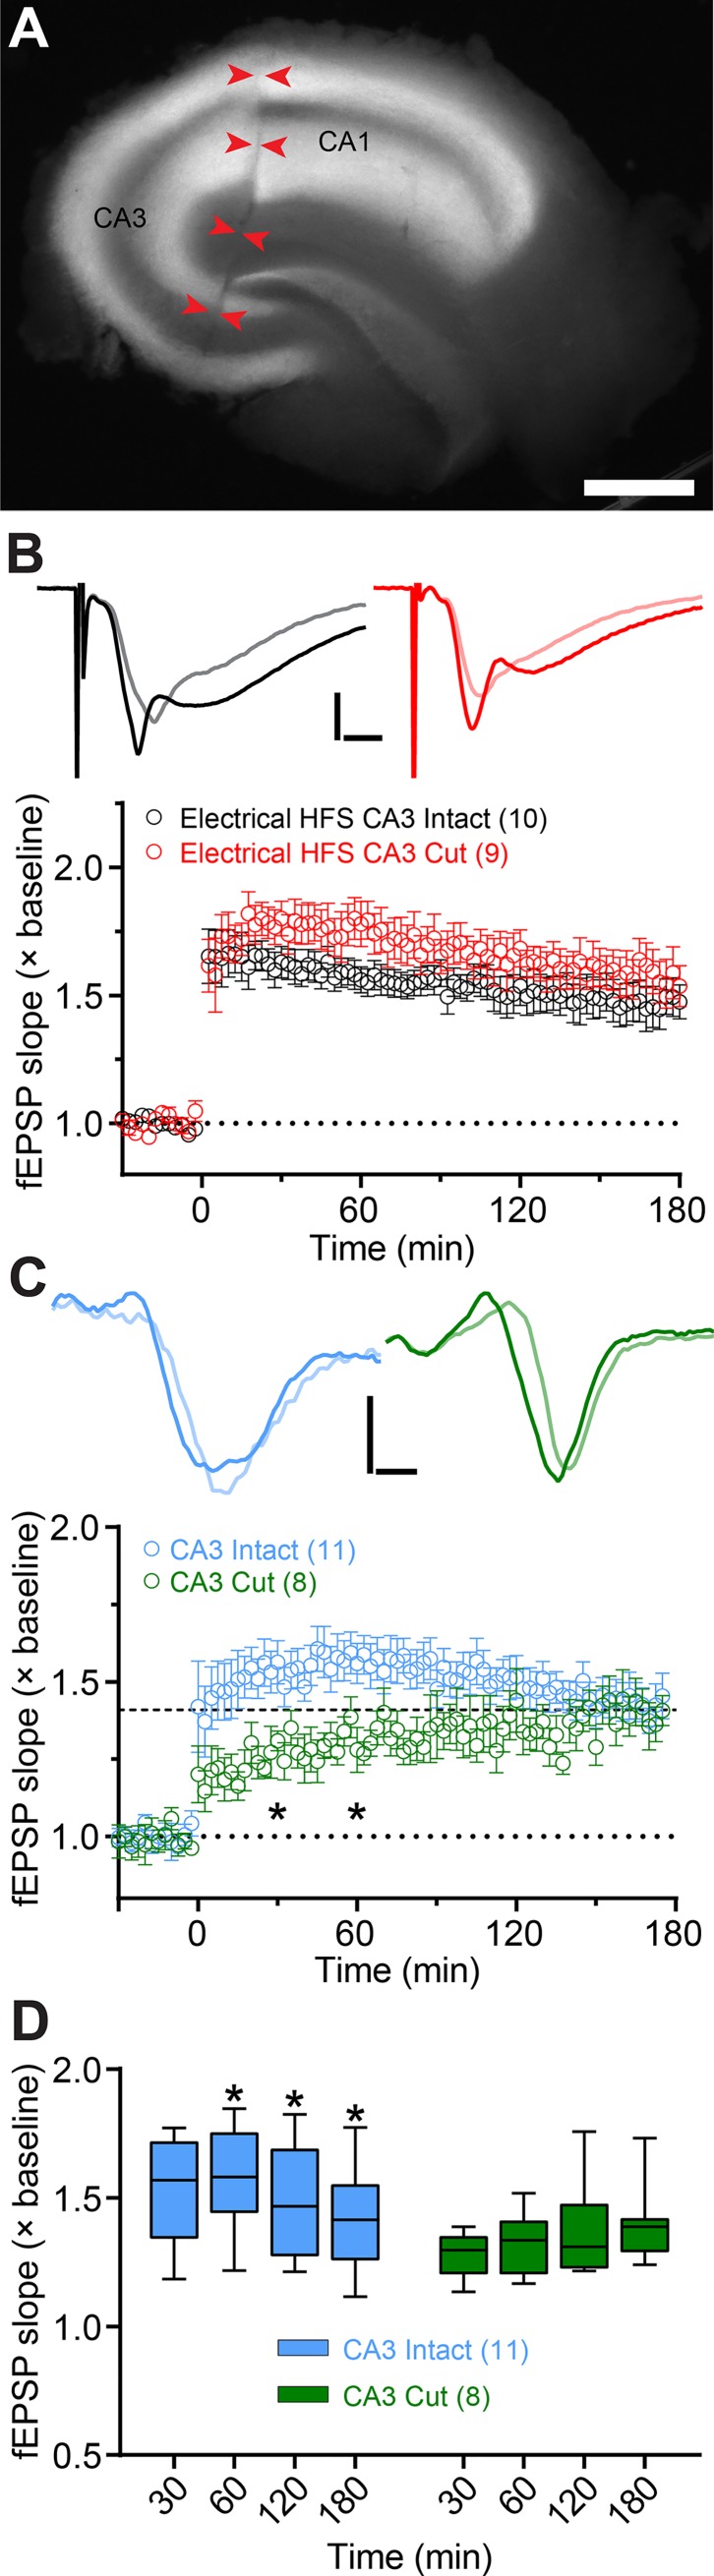
Optical stimulation of CA3→CA1 commissural fibers was sufficient for L-LTP.(A) Representative image of a contralateral slice with CA3 cut off from CA1. Scale bar = 500 μm. (B-C). LTP induced by electrical (B) and optical (C) HFS in intact and cut slices. The example traces show EPSPs recorded before (light shaded lines) and 3 hr after HFS (solid lines). Optical LTP magnitude (C) at 30 and 60 min post-HFS was significantly different between intact and cut slices (oEPSP slope F(1, 17) = 4.74, p < 0.05; Time F(3, 51) = 0.95, p > 0.05; Interaction F(3, 51) = 6.60, p < 0.0001; repeated measures two-way ANOVA with Bonferroni’s post-hoc tests). Scale bars = 2 ms, 2 mV (B); 1 ms, 0.5 mV (C). (D) Summary data for oEPSP slope change at different time points following optical HFS in intact and cut slices. The intact slices showed significant changes in LTP magnitude in the last 120 min of recordings (F(1.28, 12.8) = 5.75, p < 0.05; repeated measures one-way ANOVA). The box plots show medians and interquartile ranges, with whiskers extending from minimum to maximum values. The number of slices used for each condition is indicated in parentheses.